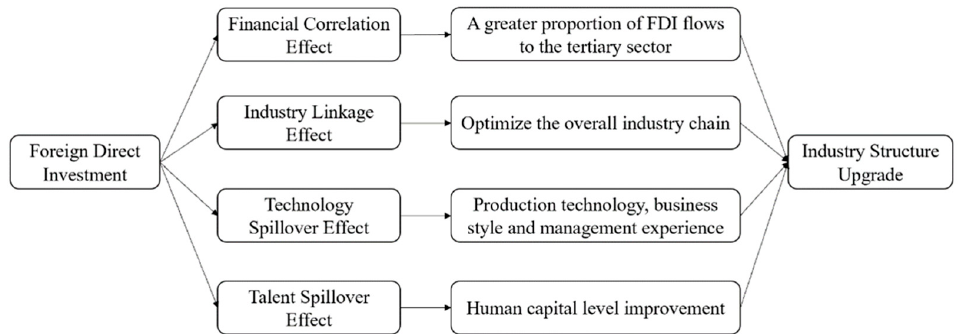
Figure 1. Influence mechanism of FDI in forestry on the forestry industry structure upgrading.